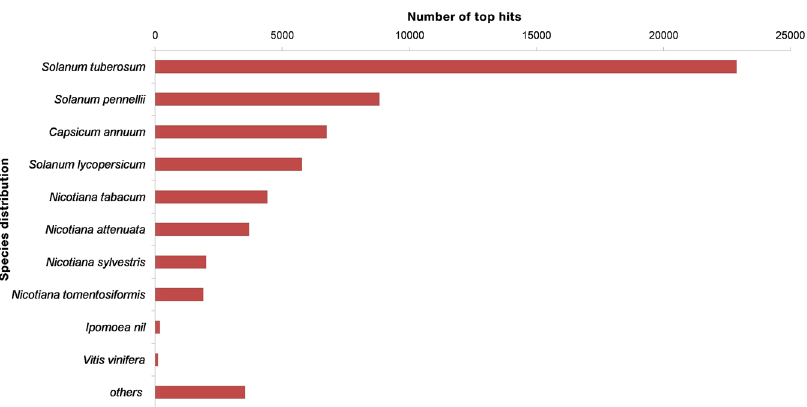
Figure 2. BLASTX top hit species distribution of Solanum trilobatum unigenes against plant nr database.